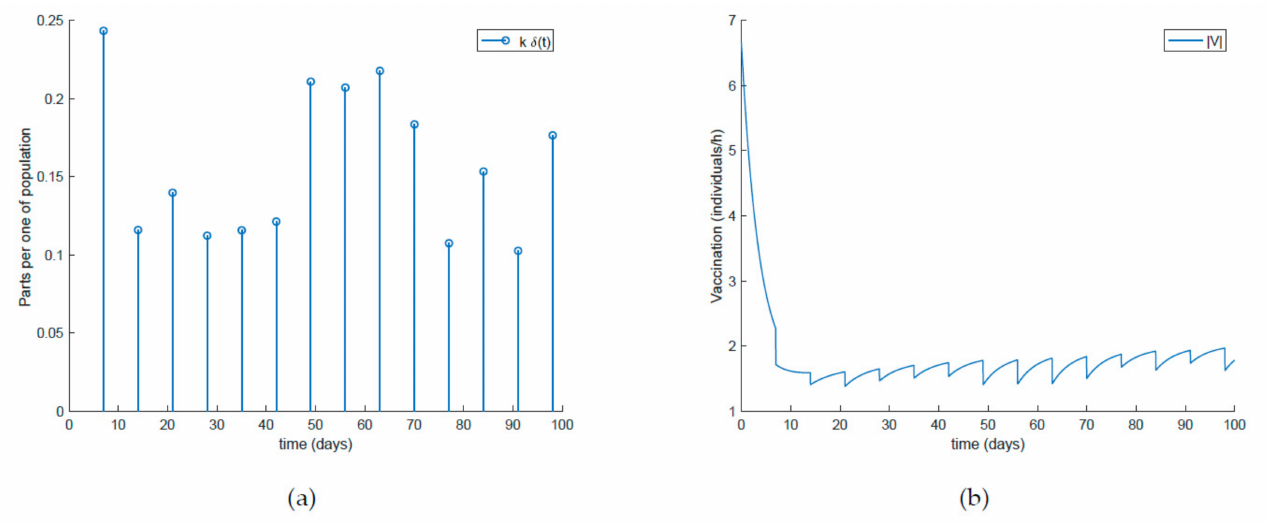
Figure 18. ( a ) Impulsive vaccination (once per week with time-varying amplitude) and ( b ) total feedback vaccination